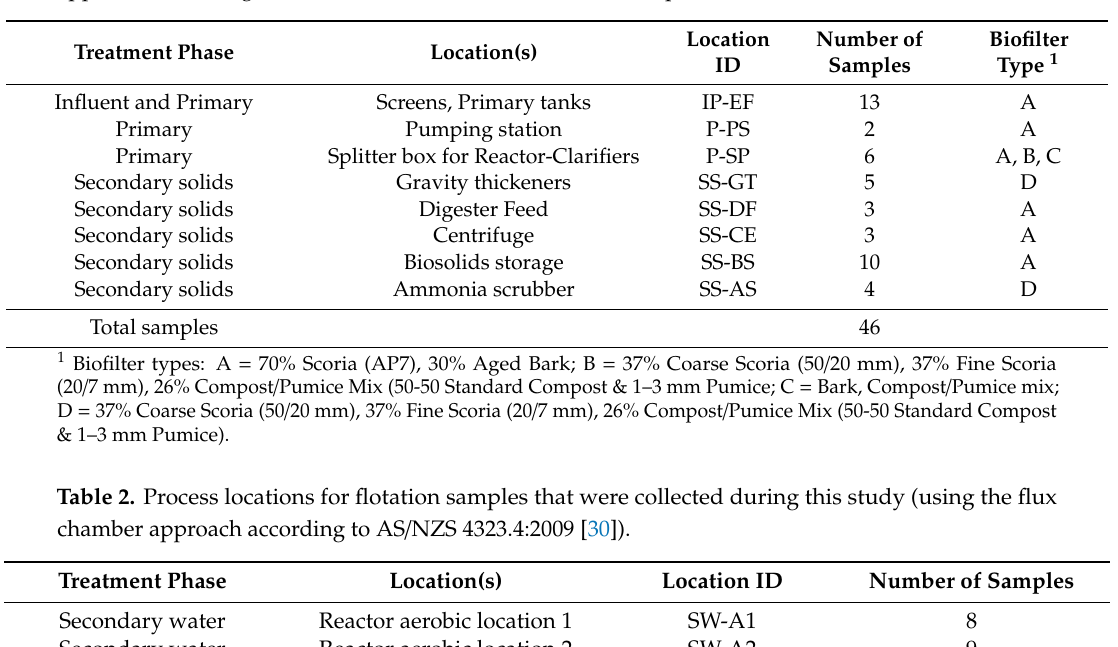
Table 1. Process locations for biofilters that were sampled in this study (using the flux chamber approach according to AS / NZS 4323.4:2009) and biofilter compositions.